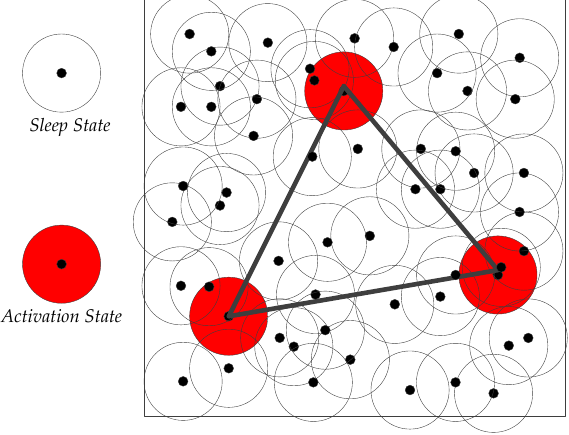
Figure 5. Schematic diagram of the 2D convex hull activation strategy.